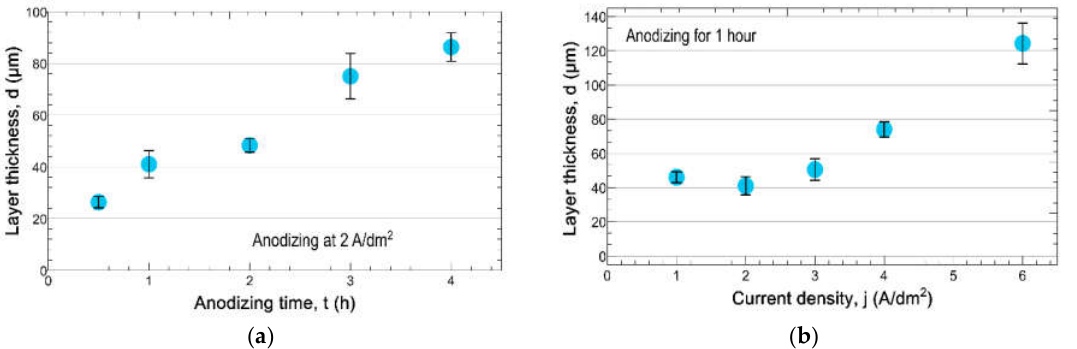
Figure 7. The thickness of layers anodized ( a ) for different times at j = 2 A/dm 2 and ( b ) at different current densities for 1 h. current densities for 1